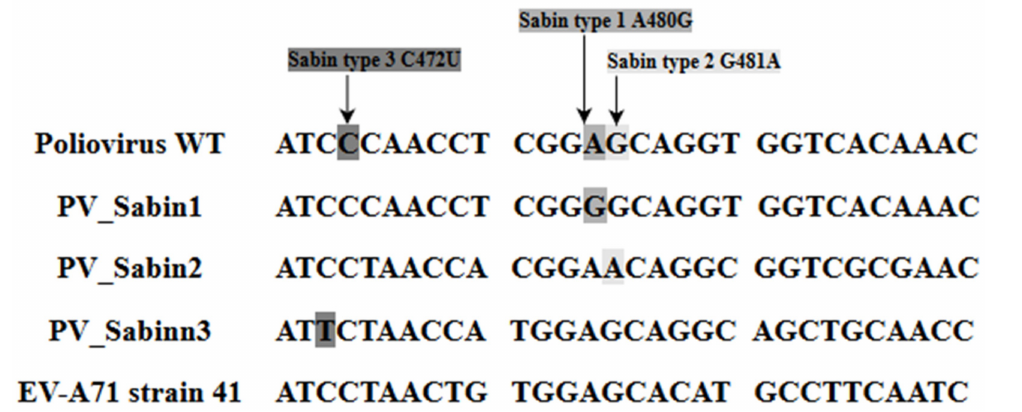
Figure 3. Comparison of the nucleotide sequence between the Wild Type Poliovirus, Poliovirus Sabin Strain 1, 2 and 3 and EV-A71 strain 41(GenBank: AF316321). PV Sabin 1, PV Sabin 2 and PV Sabin 3 contain altered nucleotides in the 5 (cid:48) -NTR of ssRNA. Shaded areas in different shades of grey indicate the location where the altered nucleotides are. Table 2. Comparison of nucleotide and amino acid identities between the prototype strain of EV-A71 (BrCr), Coxsackie A16 and wild type Poliovirus. The comparison among the different enteroviruses was reported throughout specific regions of the genome from 5 (cid:48) -NTR, P1, P2, P3 and 3 (cid:48) -NTR [13]. Nucleotide Identity of Strain EV71/MS/7423 with Other Enteroviruses Whole Genome 5 (cid:48) -NTR P1 P2 P3 3 (cid:48) NTR EV-A71/BrCr 81 85 82 77 80 92 Coxsackie A16 77 86 68 82 79 79 Poliovirus 58 71 53 58 61 41 Amino Acid Identity of Strain EV71/MS/7423 with Other Enteroviruses Whole Genome P1 P2 P3 VP1 VP2 VP3 VP4 EV-A71/BrCr 95 97 94 94 93 99 99 100 Coxsackie A16 89 79 95 95 71 84 84 78 Poliovirus 55 46 59 62 36 55 45